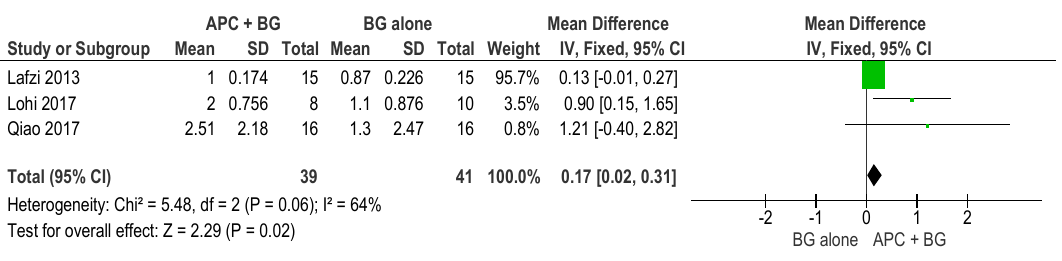
Figure 12. Forest plot showing the effect on horizontal furcation length for comparison of APC + BG versus BG alone at end of all-follow-up (6–12 m) .